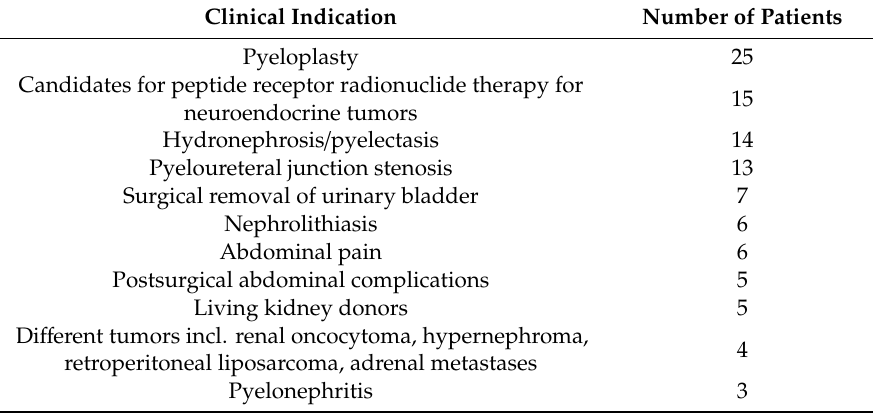
Di ff erent tumors incl. renal oncocytoma, hypernephroma, retroperitoneal liposarcoma, adrenal